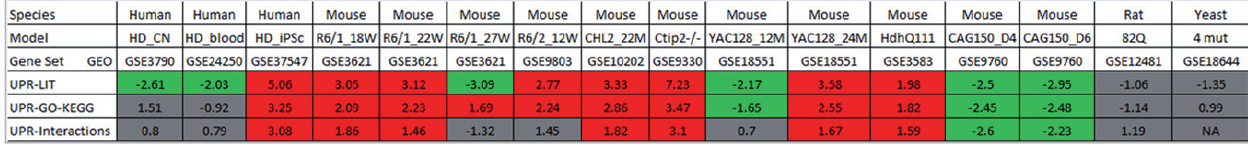
Figure 2. Differential regulation of UPR gene sets detected in HD expression data. For each of the compiled UPR genes sets, the normalized enrichment scores (NES) produced by GSEA are shown for different comparisons of HD-associated expression with controls. Positive scores indicate a tendency towards upregulation; negatives scores indicate a tendency towards downregulation of genes in the UPR sets. Comparisons that showed significant upregulation of UPR gene sets ( fdr ≤ 0.05 and NES ≥ +1.4) are highlighted by red background, while significant downregulation ( fdr ≤ 0.05 and NES ≤ +1.4) by green